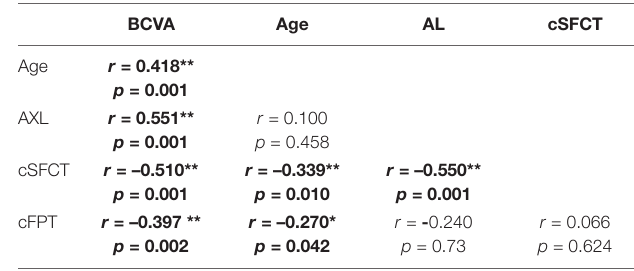
TABLE 3 | Pearson correlation between study